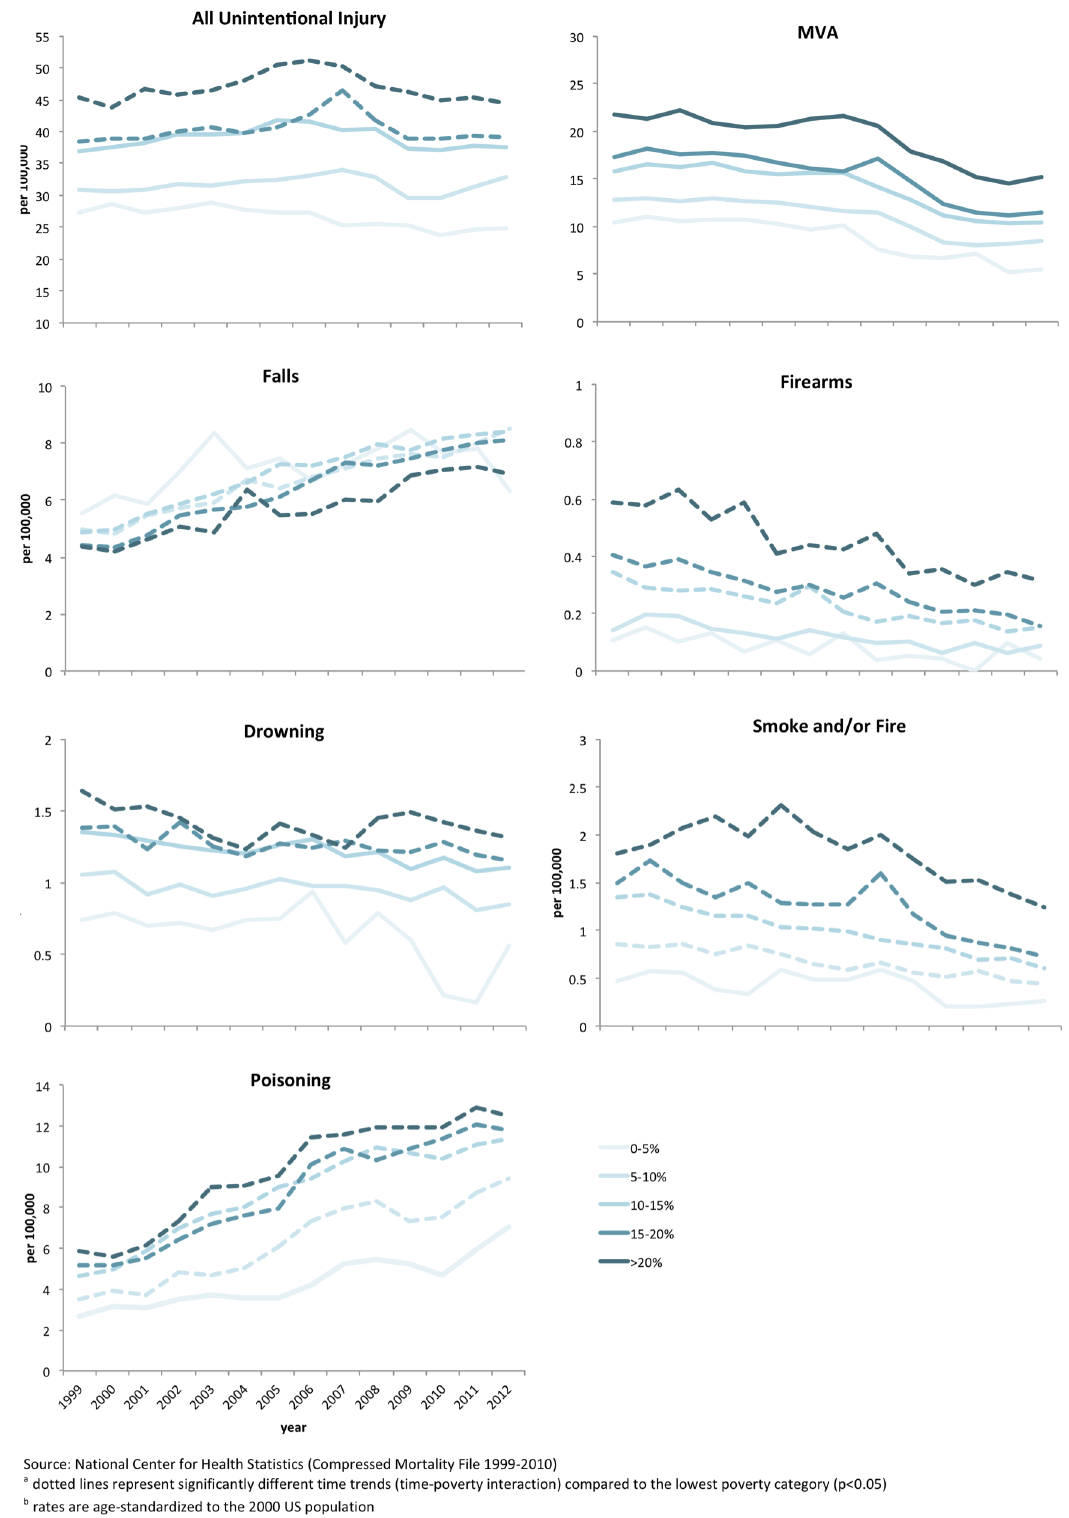
Fig 1. Trends in Mortality for All Unintential Injuries and Specific Causes by County Poverty Rates, US 1999 – 2012.